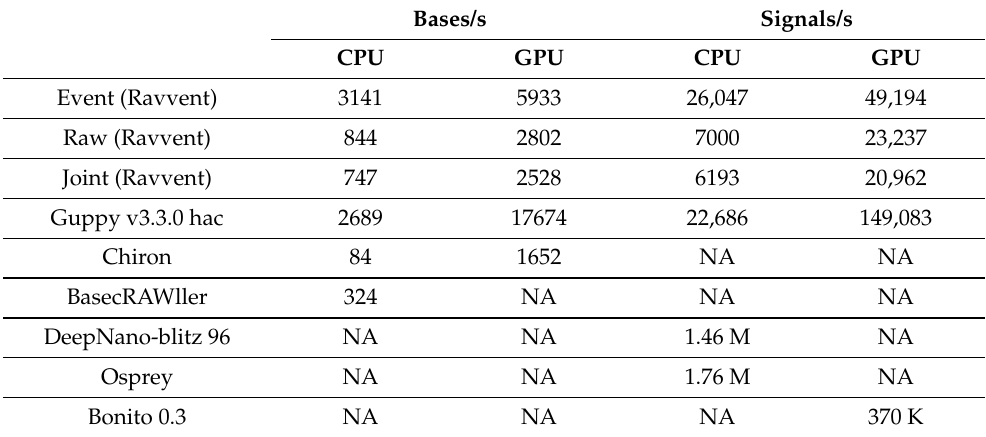
Table 3. Comparison of basecalling